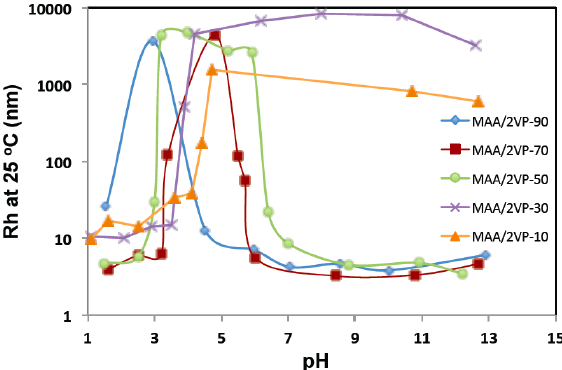
Figure 3. Particle size (hydrodynamic radius) of methacrylic acid/2-vinylpyridine (MAA/2VP) copolymers in aqueous solutions at pH ranged from 1–14. The sample composition is denoted by MAA/2VP-xx where xx refers to the mol% of MAA units in the copolymer.